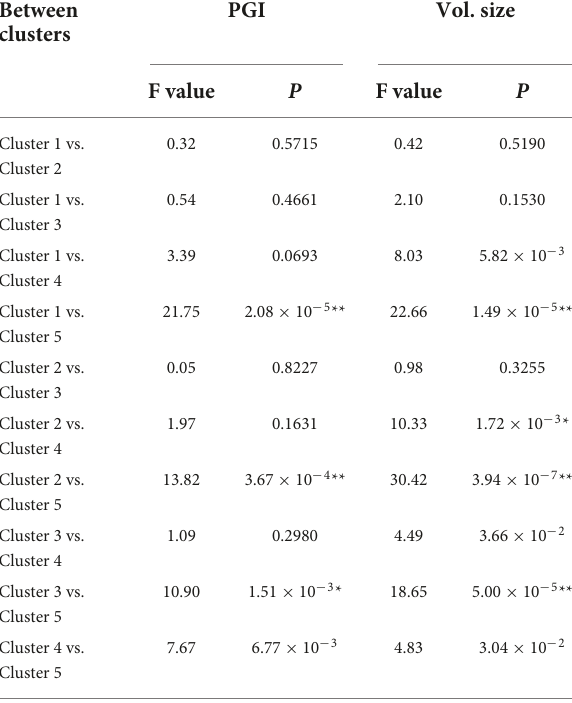
analyses are also included. It is worth noting that among the shape clusters in the S s group ( Table 4 and Figure 6A ), cluster 5 is significantly different from the other four clusters in terms of both PGI and lesion size. However, the PGI difference in cluster 5 from other four clusters was not likely driven by the lesion size because this cluster contains size evenly distributed between 30 and 250 voxels. For the S l group, significant PGI differences were only found between Clusters 1 and 4 and between Clusters 2 and 4 ( Table 5 and Figure 6B ). However, due to the large lesion size variance in each cluster, there was no significant difference in lesion size among the shape clusters ( Table 2 ). Furthermore, significant PGI differences were found between cluster 4 and the other three clusters ( Table 6 ). Of note, compared with the other three clusters, the average PGI value of cluster 4 is smaller and the texture color is lighter (e.g., high intensity) ( Figures 8 , 9